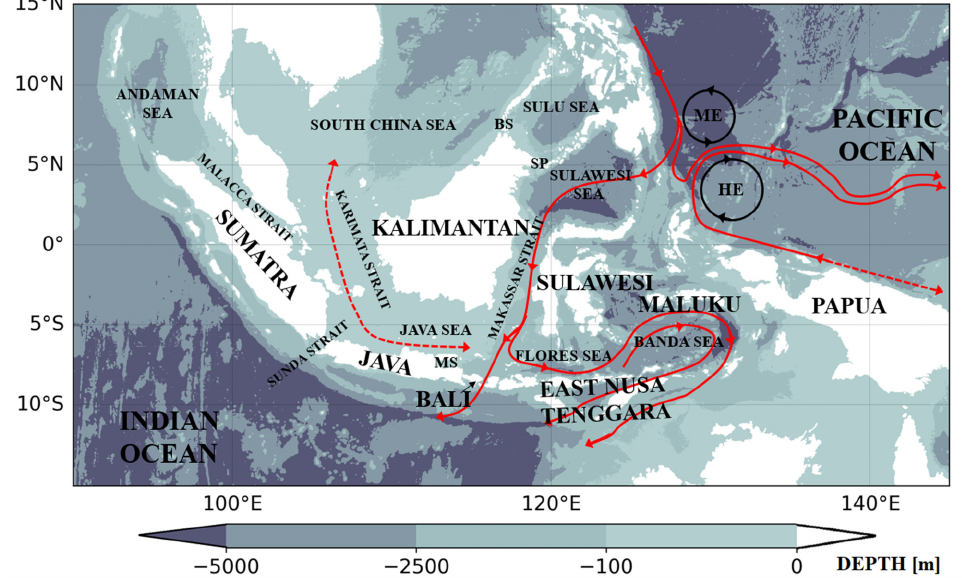
Figure 1. Indonesian region bathymetry, main islands and currents. Shades of blue-gray illustrate the bathymetry (in meters). Red lines and arrows illustrate the Indonesian throughflow. Dashed lines illustrate two currents reversing with the monsoons (southeastward during the North Monsoon centered on July and August and northwestward during the South Monsoon centered on January and February). Acronyms: ME, Mindanao Eddy; HE, Halmahera Eddy; BS: Balabac Strait; SP: Sibutu Passage; MS, Madura